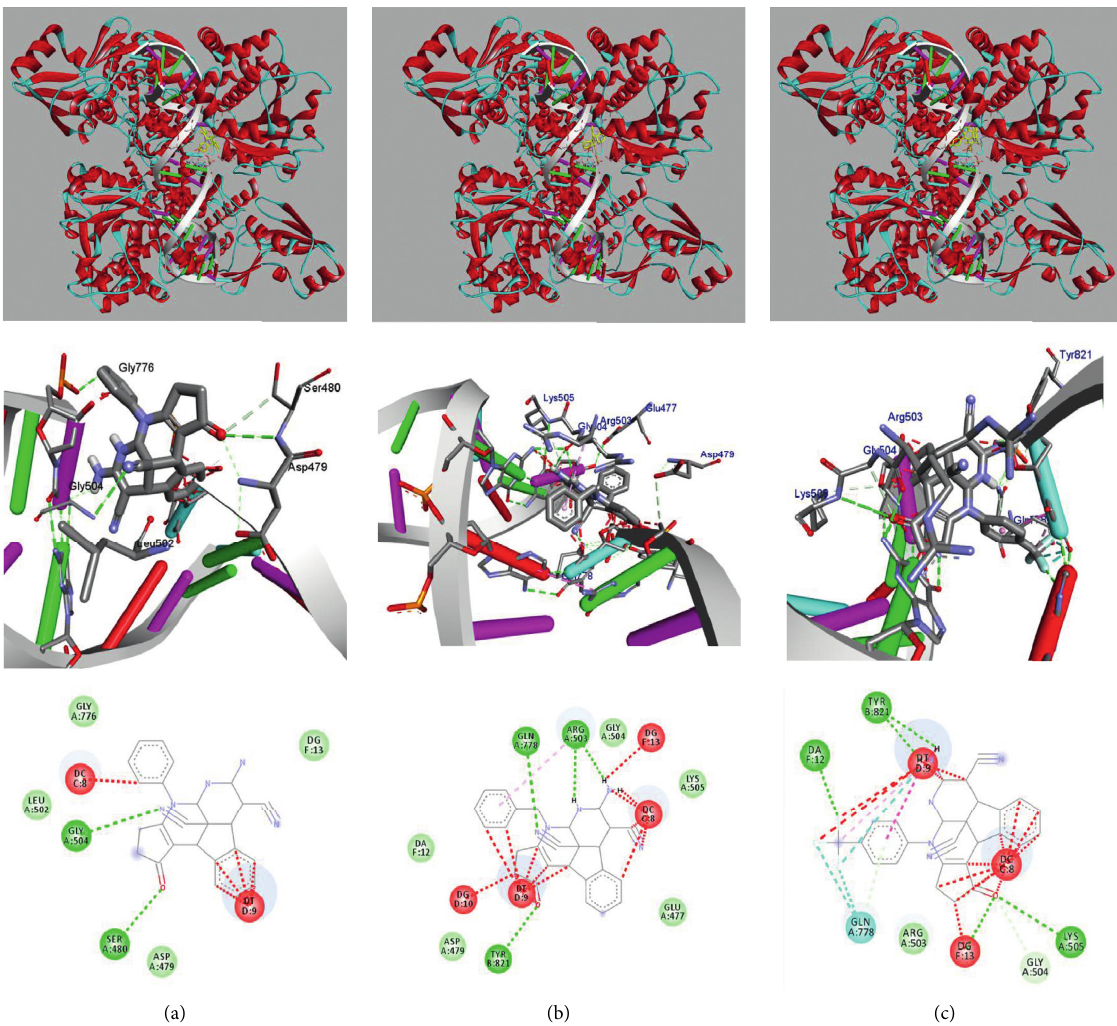
Figure 2: The 2D and 3D binding interactions of compounds 6b, 6d, and 6i (comparable to Vosaroxin) against human topoisomerase II β (PDB ID: 3QX3). 3D ribbon model shows the binding pocket structure of human topoisomerase II β with compounds. Hydrogen bonds between compounds and amino acids are shown as green-dashed lines, and hydrophobic interactions are shown as pink lines. (a) 6b, (b) 6d, and (c) 6i. Table 5: Molecular docking results of compounds 6a-i against E. coli DNA gyrase B (PDB ID 6F86). S.